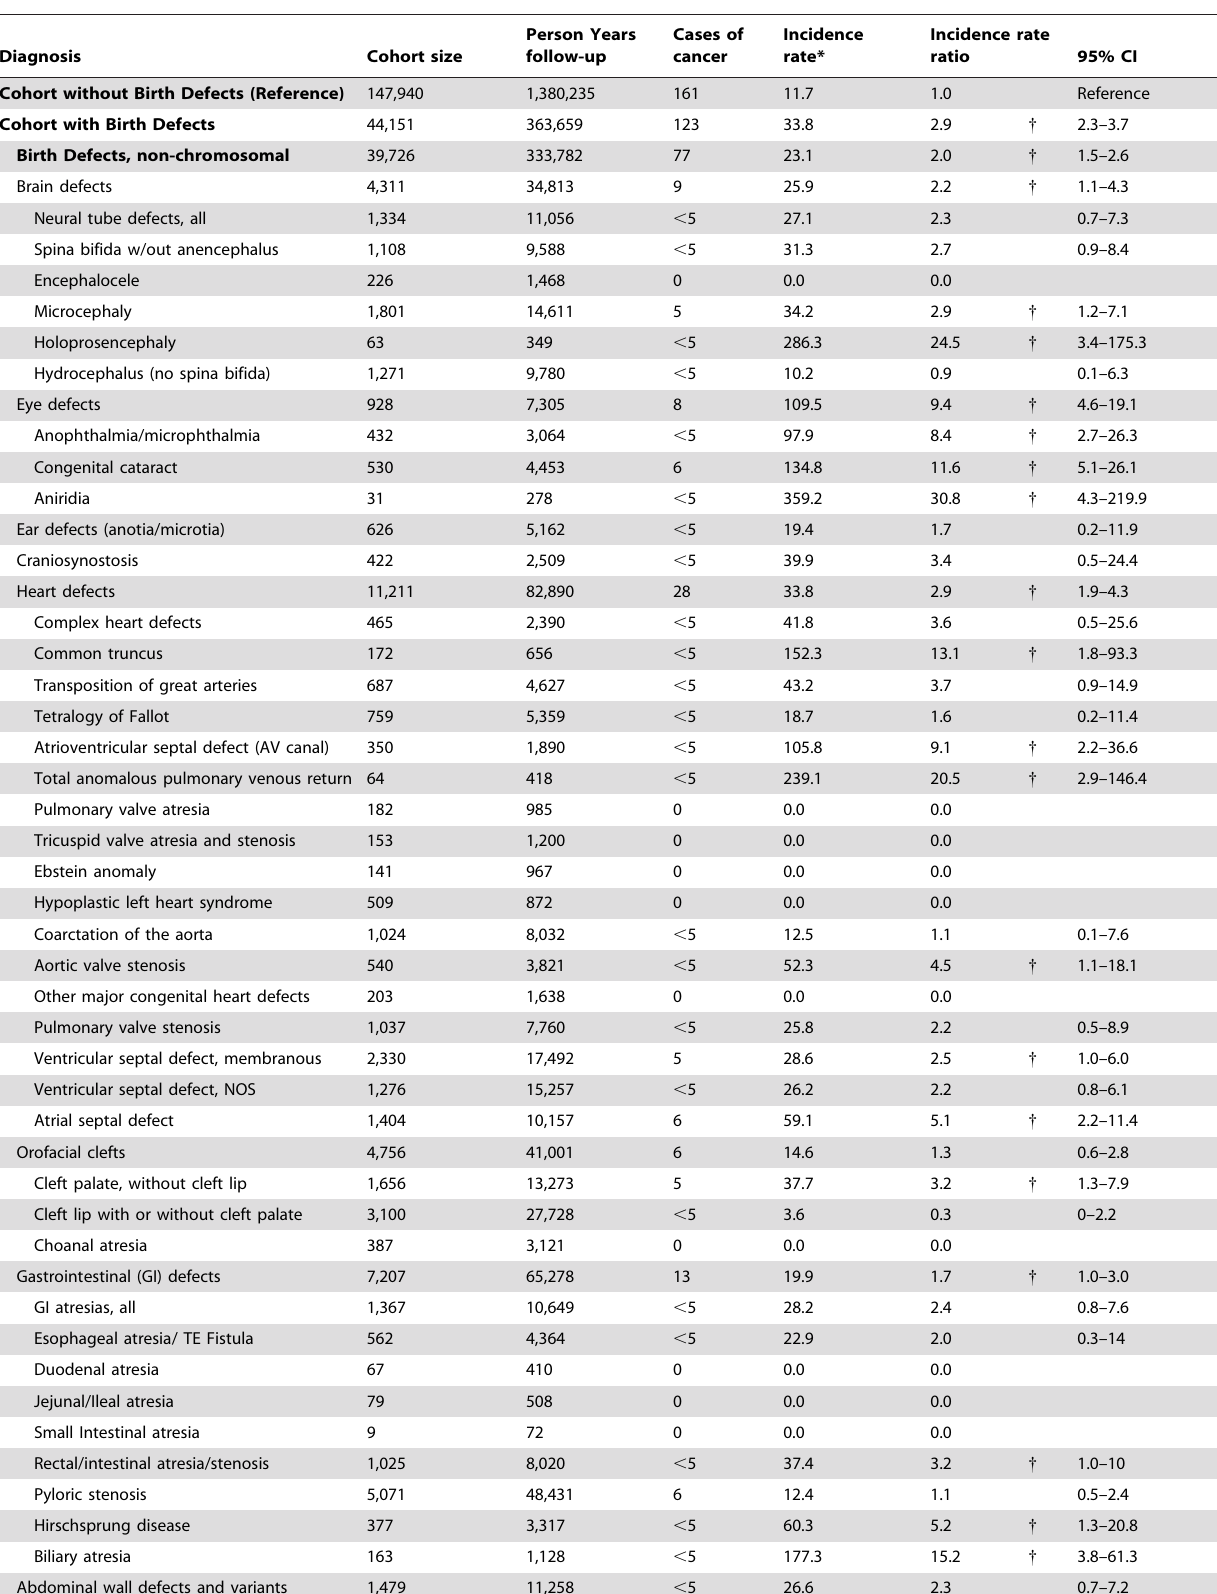
Table 3. Risk for cancer by type of chromosomal anomaly and major birth defect, UTAZIA